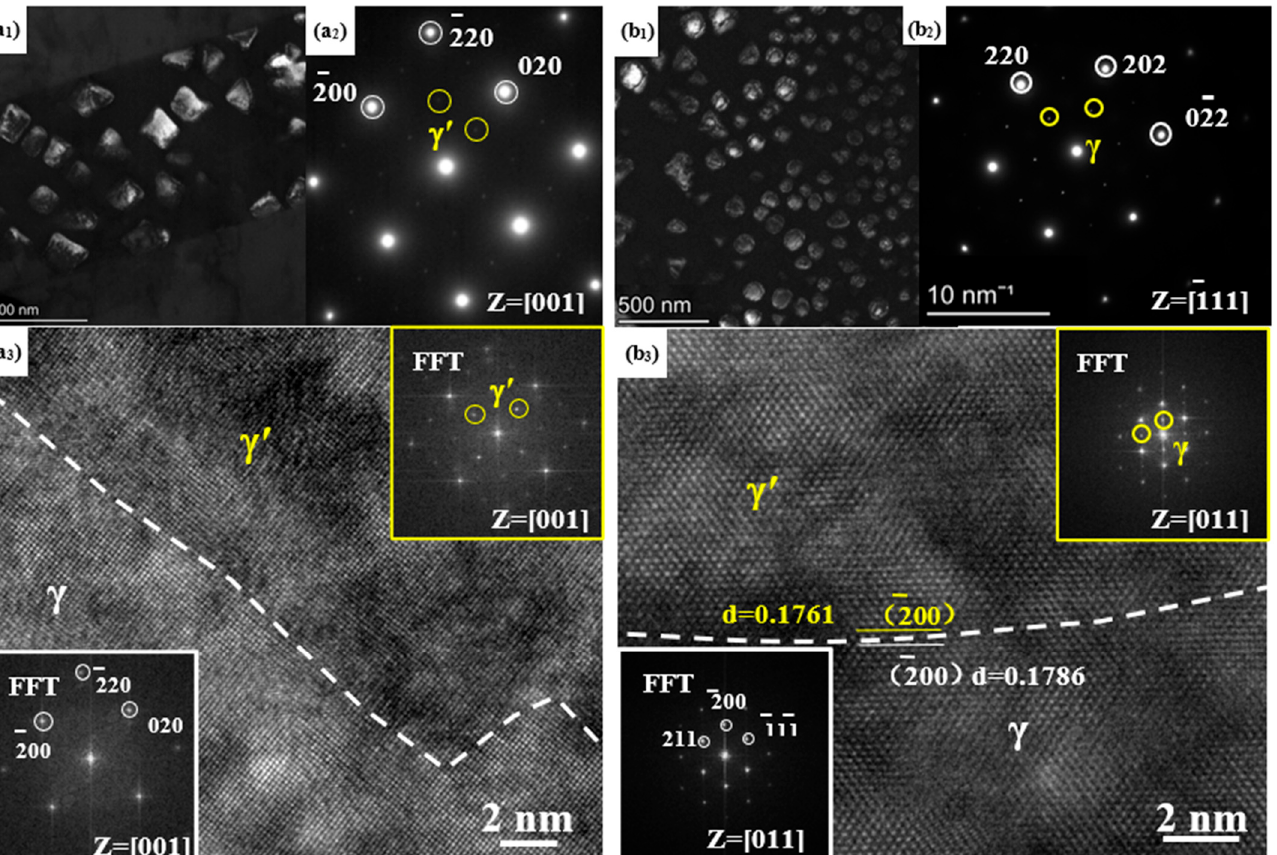
Figure 5. TEM result of phase with different morphologies: ( a 1 ,b 1 ) the dark image of phase, ( a 2 , b 2 ) the SAED image of phase, ( a 3 , b 3 ) the HRTEM image of phase interface